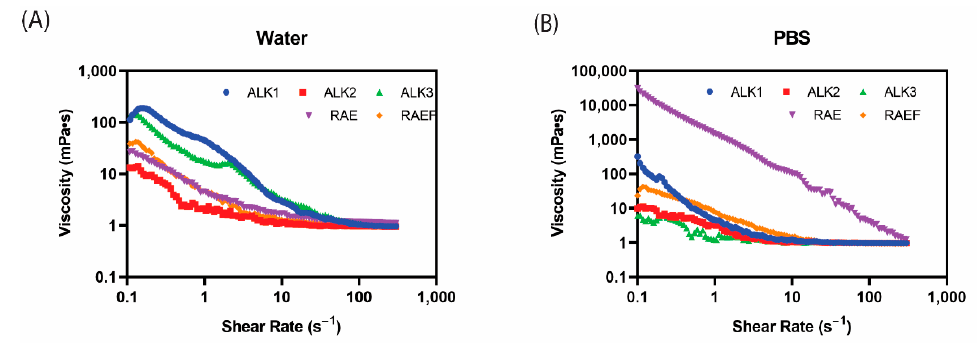
Figure 2. Peptides were prepared using film dehydration and then resuspended in either ( A ) water or ( B ) PBS. Samples were examined at shear rates from 1–300 Hz, and viscosity was plotted using Rheocompass.